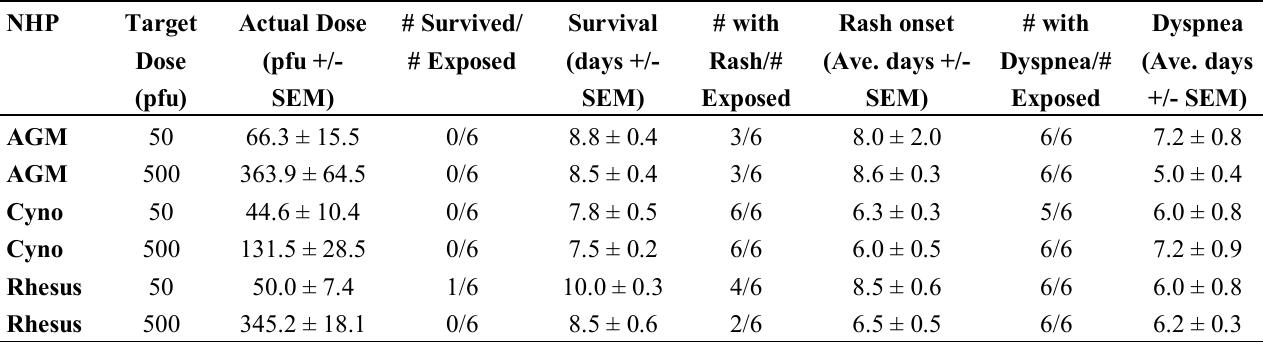
Table 1. Summary of outcome of aerosolized Sudan virus (SUDV) exposure in non-human primates